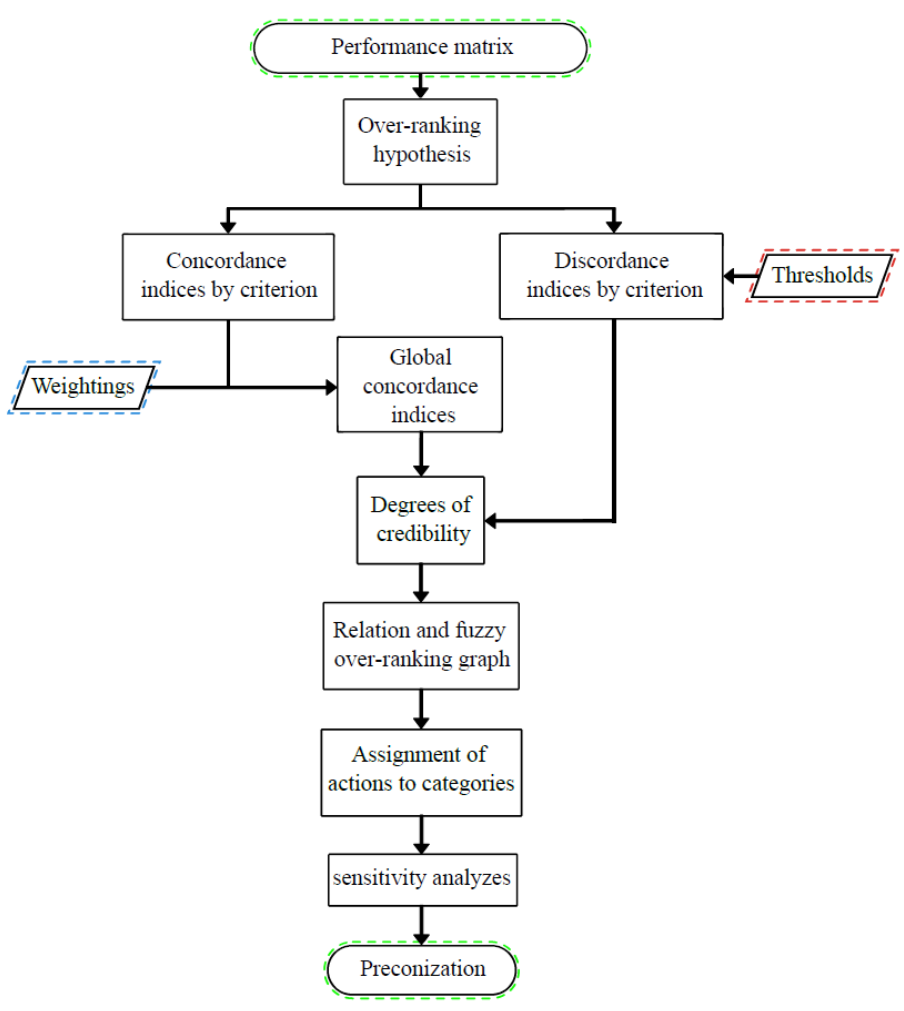
Figure 9. Flow chart of the ELECTRE Tri procedure.